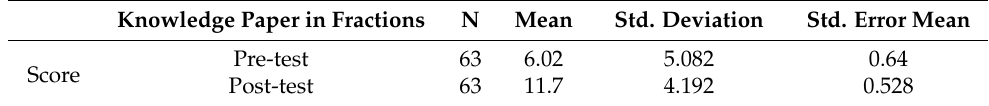
Table 7. Performance of E.G.—Intervention Program.